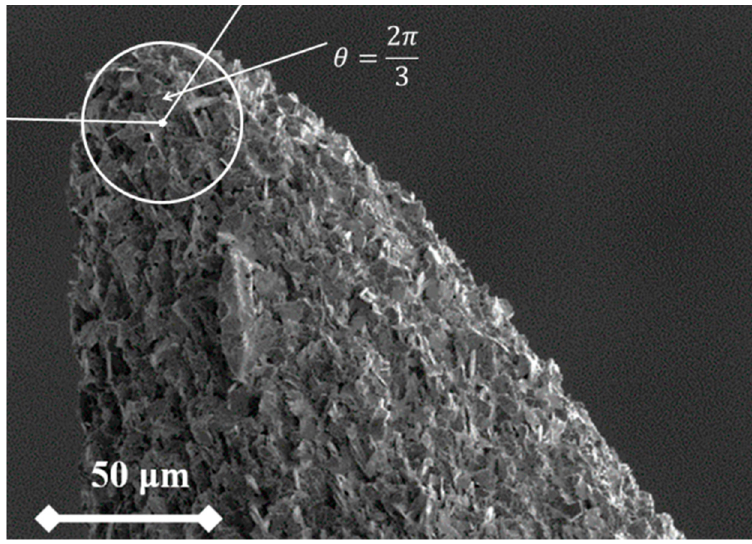
Figure 8. Calculation of the macroscopic area. For the illustration, the HB polymer graphite (PG) rod image was used.